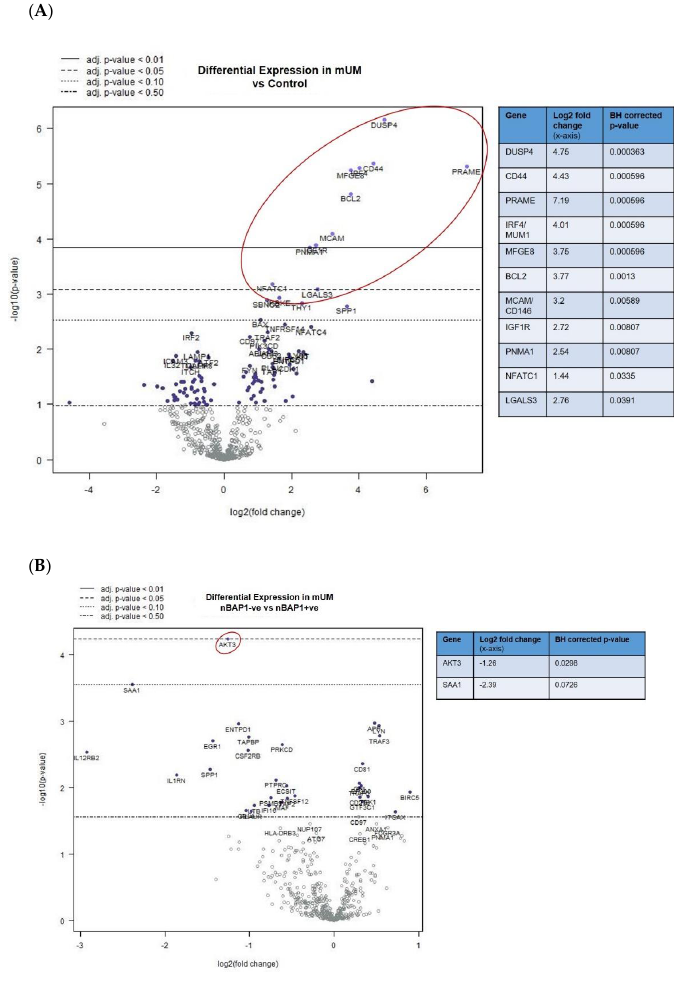
Figure 3. Differential gene expression profiles presented as volcano plots for: ( A ) all mUM versus control liver and ( B ) nBAP+ve mUM versus nBAP-ve mUM. The log 2 fold changes with cut-offs for adjusted p -values are shown. The genes of interest (marked fold changes and statistically significant) are highlighted (red outline and inset table). (Table S3 gives more detailed output for each gene). The pairwise comparisons of Intersegmental mUM from the same patient (representative scatter plot in Figure 4A) showed that there was significant variability of all immune-related genes between the different mUM lesions for each case. The genes consistently highly expressed in mUM from different liver segments included : HLA-A , HLA-B , HLA-C (major histocompatibility class I), and